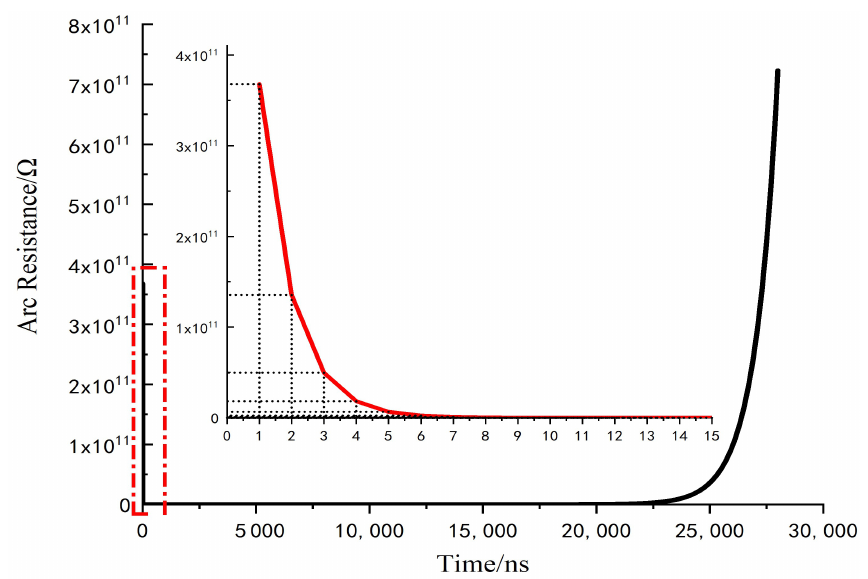
Figure 4. Curve of the arc resistance R ( t ) with time